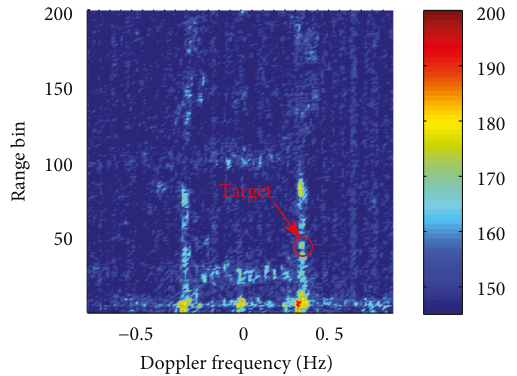
Figure 17: Range-Doppler maps by the IMLC